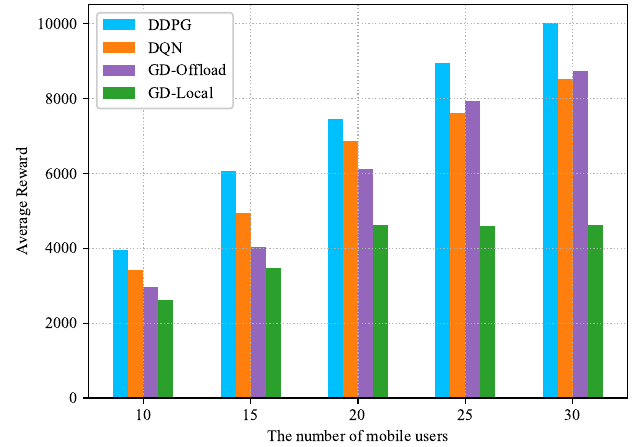
Figure 12. Average reward versus the number of mobile users.